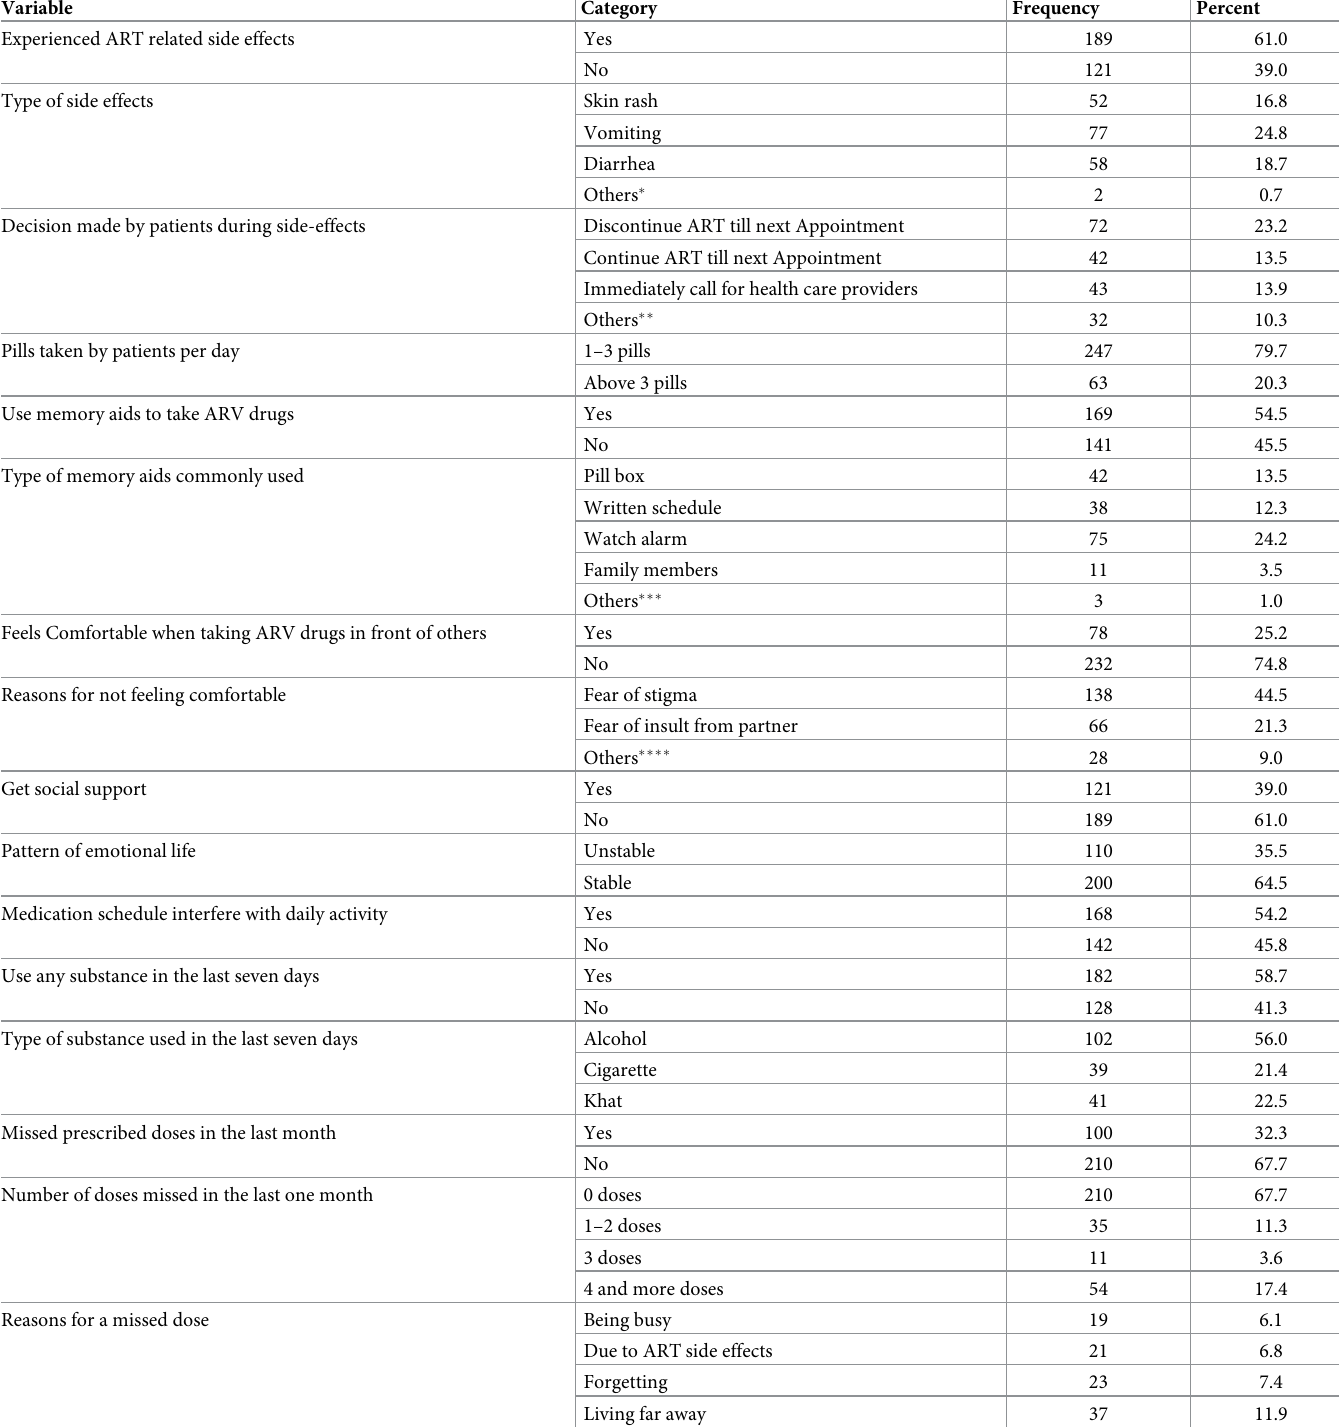
Table 3. Behavioral, psycho-social, health service, and ART drug-related information among adults on ART at public health facilities of North Shew Zone, Amhara Regional State, Ethiopia,